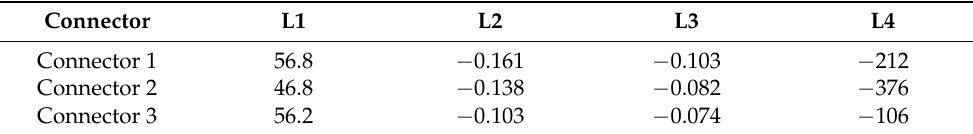
Table 3. Constant values of Equation (4) for each